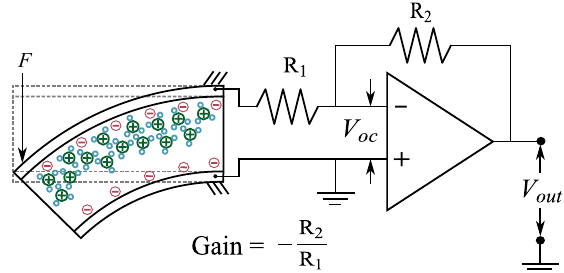
Figure 6. Implementation principle of IPMC voltage